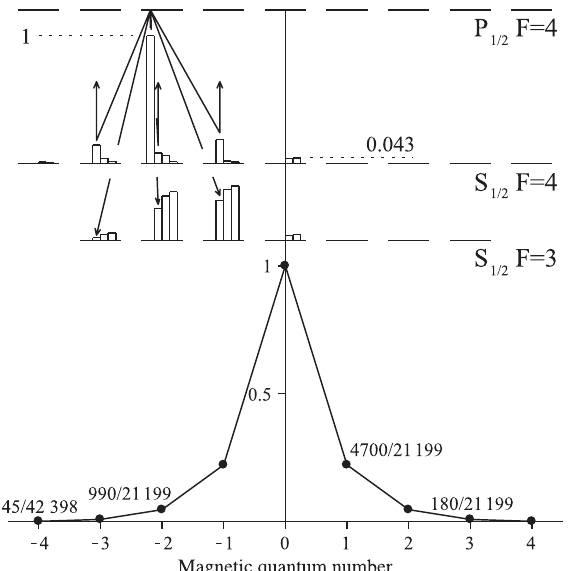
TABLE II. For I ¼ 7 = 2 , the probability p that an atom M j 4 ; 4 i remains in the F ¼ 4 hyperfine initially in the state S 1 = 2 , level after being pumped with light tuned to the transition S 1 = 2 F ¼ 4 ! P , F 0 , that propagates in the z direction, and is j 0 circularly polarized with positive j 4 ; M i , undergoes a FIG. 2. An atom, initially in the state S 1 = 2 large number of cycles of absorption of laser photons, followed to be the by spontaneous emission. We define the probability p M probability that an atom, illuminated with a (cid:5) -polarized laser , F ¼ 4 to P , F ¼ 4 , ends in the tuned to the transition S 1 = 2 1 = 2 j 4 ; 0 i state instead of ending in some state in the S , dark S 1 = 2 1 = 2 F ¼ 3 hyperfine level, after many cycles of absorption and spontaneous emission. In the upper half of the figure, the arrows show the pattern for the first spontaneous emission and re- j 4 ; (cid:2) 2 i , and the excitation for an atom initially in state S 1 = 2 histograms show how the probability of being in any given level evolves after 0, 1, 2, or 3 spontaneous emissions. The probability j 4 ; 0 i state involves processes of ending in the dark S 1 = 2 j 4 ; (cid:2) 2 i ! P j 4 ; (cid:2) 2 i ! S j 4 ; (cid:2) 1 i ! P j 4 ; (cid:2) 1 i ! like S 1 = 2 1 = 2 1 = 2 1 = 2 j 4 ; 0 i and similar. Values for p S are in the graph in the lower M 1 = 2 half of the figure; they correspond to those given in the second column of Table I.